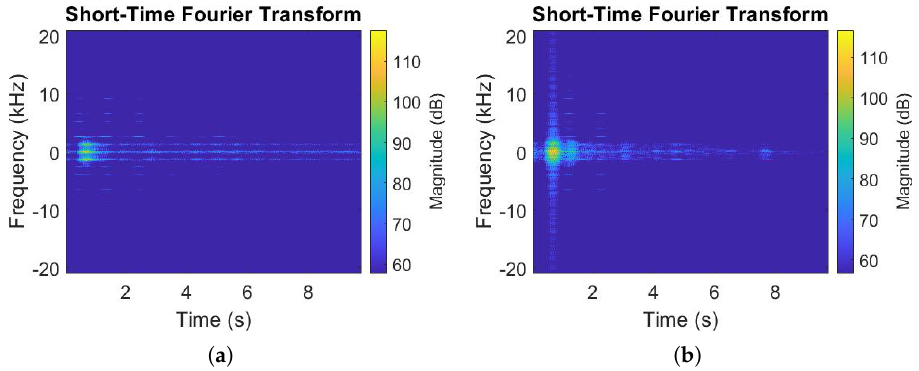
Figure 6. Spectrogram examples. ( a ) One target. ( b ) Two